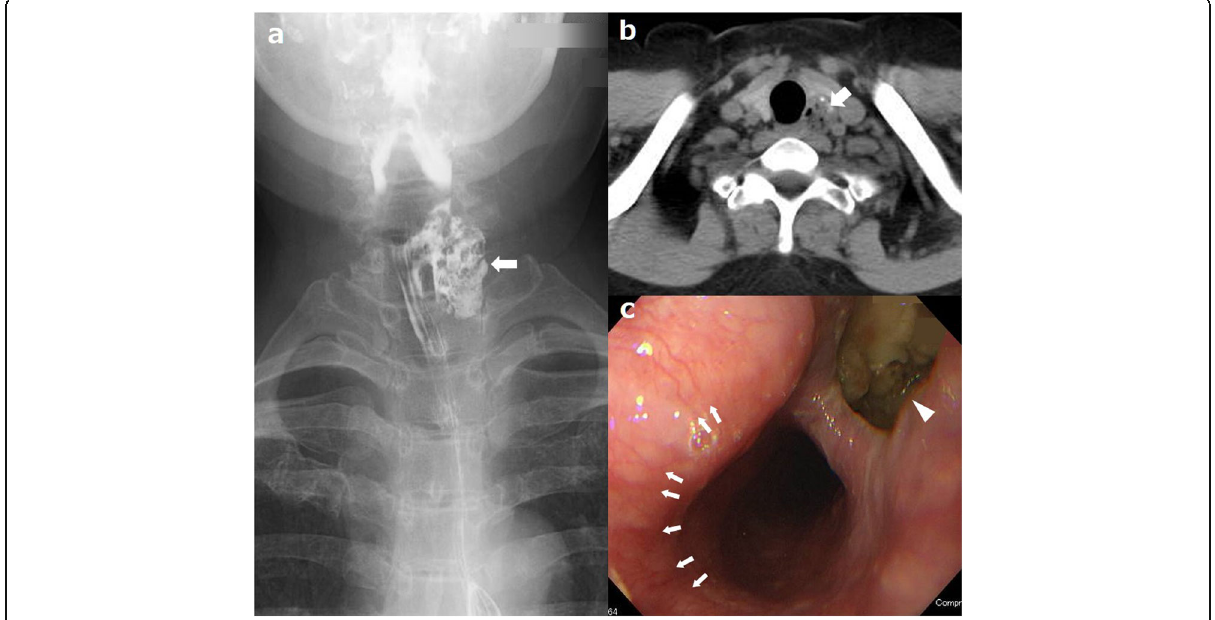
Fig. 1 Preoperative findings. a Contrast esophagography showing a diverticulum 3 cm in diameter on the left side of the cervix (arrow) but not the cricopharyngeal bar. b Cervical computed tomography showing an air-filled diverticulum (1.6 × 1.8 × 3.2 cm) arising from behind the left lobe of the thyroid (arrow). c Upper endoscopy showing a diverticulum filled with food residue (arrowhead) just below the palisade vessels corresponding to the level of the UES